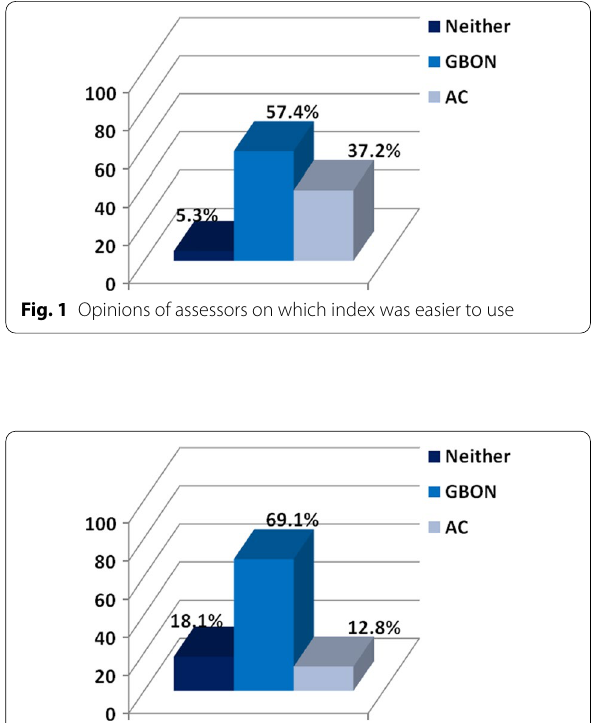
Fig. 2 Opinions of assessors on which index was felt to be more